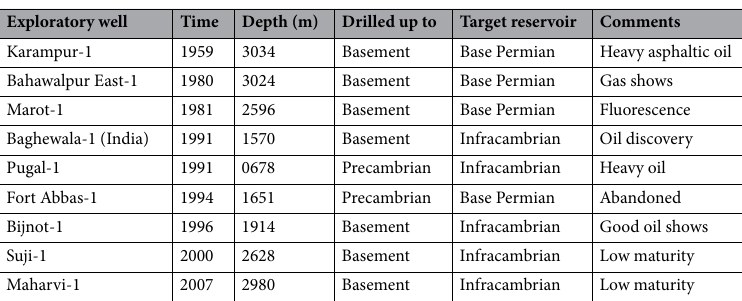
Exploratory well Time Depth (m) Drilled up to Target reservoir